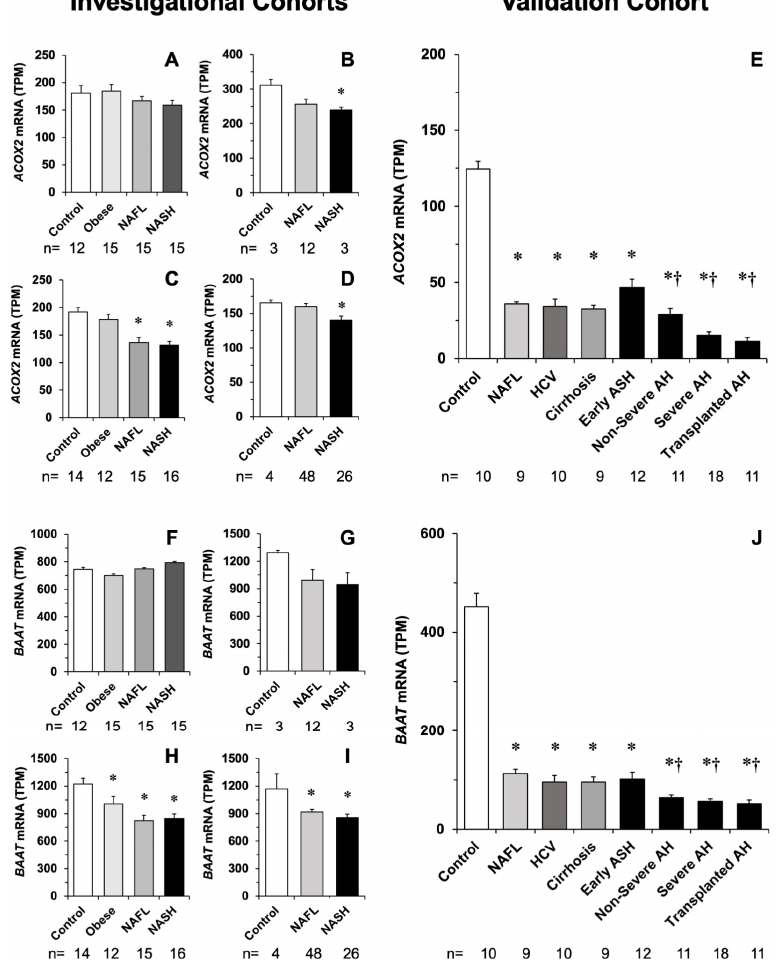
Figure 5. Abundance of ACOX2 and BAAT mRNA (TPM) in the liver of patients belonging to four investigational cohorts, whose information is available in databases GSE105127 ( A , F ), GSE115193 ( B , G ), GSE126848 ( C , H ) and GSE130970 ( D , I ). Determination of mRNA abundance by similar meth- ods in a validation cohort with different liver diseases ( E , J ). ANOVA, followed by the Bonferroni method of multiple-range testing was used for statistical analysis. *, p < 0.05 as compared with Control; †, p < 0.05 as compared with early ASH.